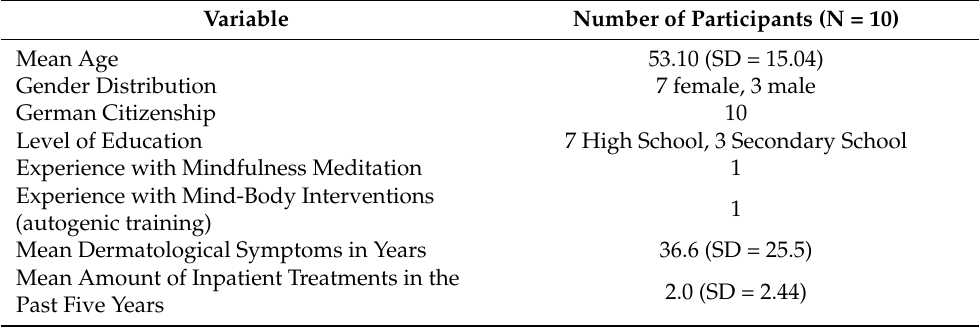
Table 1. Sociodemographics are